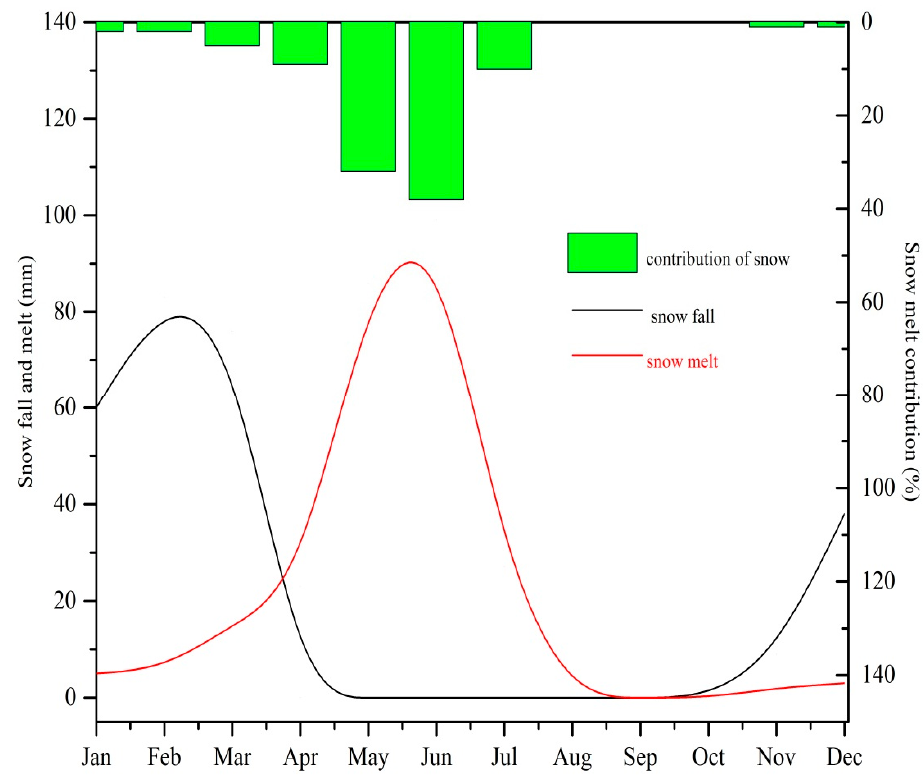
Figure 29. Snow characteristics of the western Himalayas.